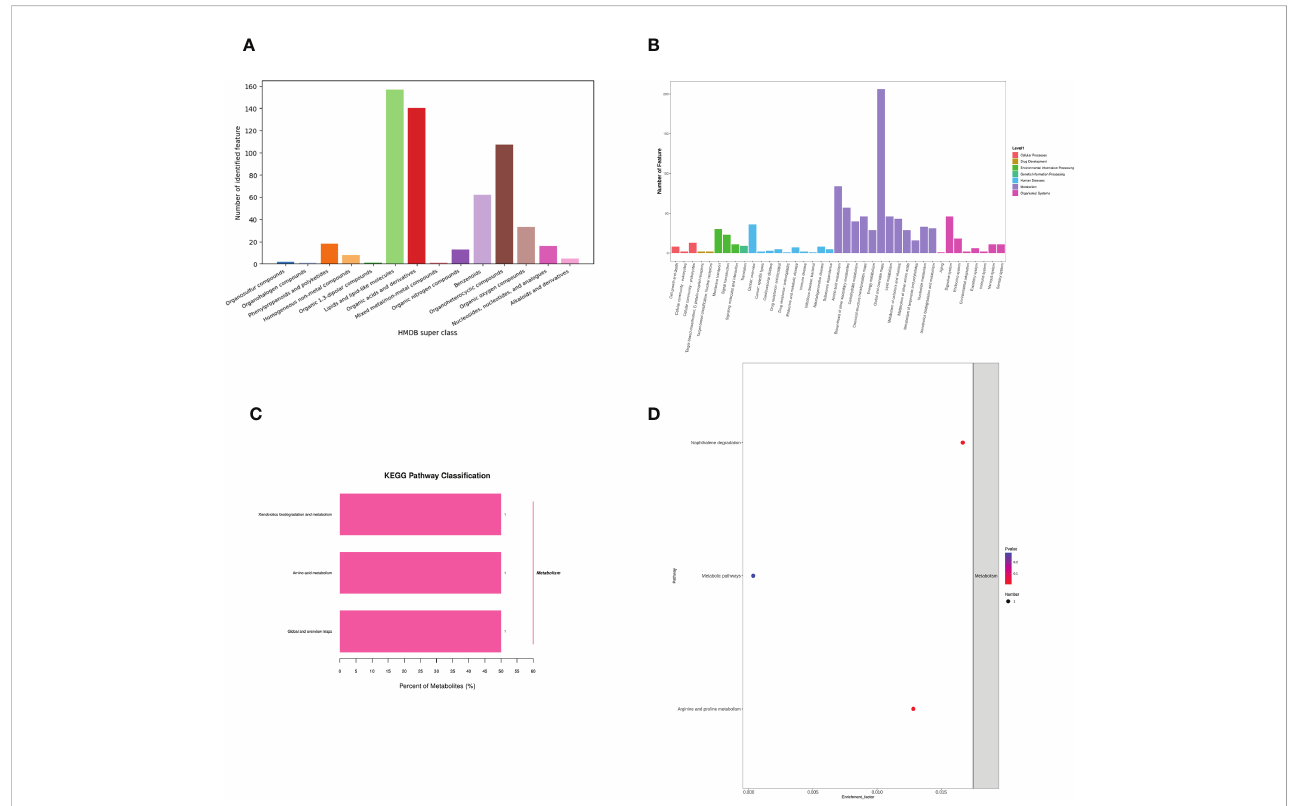
FIGURE 8 Effects of C. butyricum on the metabolic pathway and metabolism of goats after LPS challenge. (A) HMDB super class classi fi cation chart; (B) KEGG access notes; (C) KEGG pathway classi fi cation; (D) KEGG Enrichment Bubble Diagram.